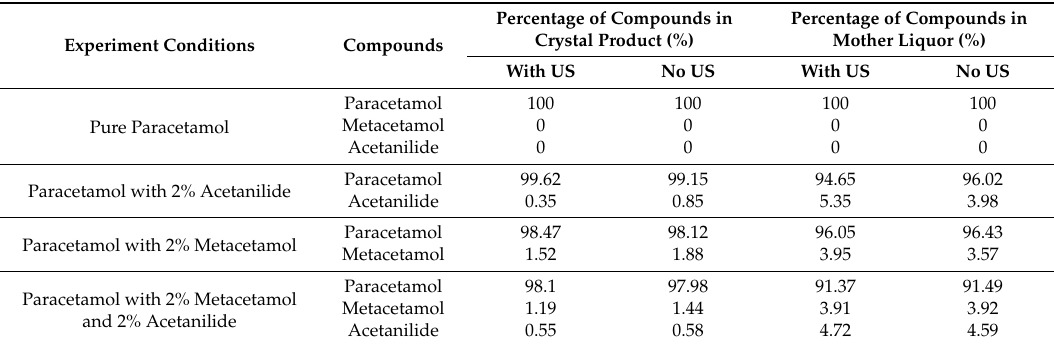
Table 4. Summary of percentage of each compound in crystal product and in mother